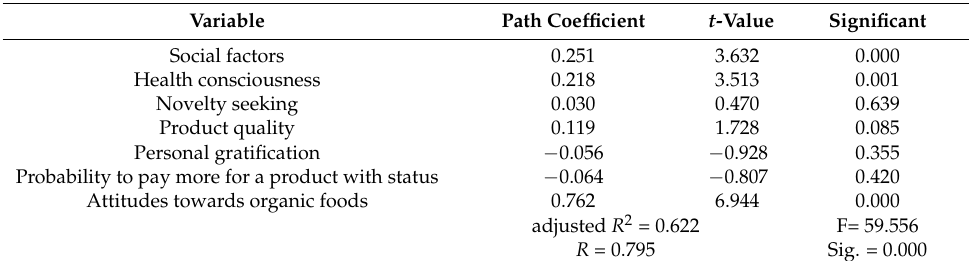
Table 3. Regression to determinants of purchase